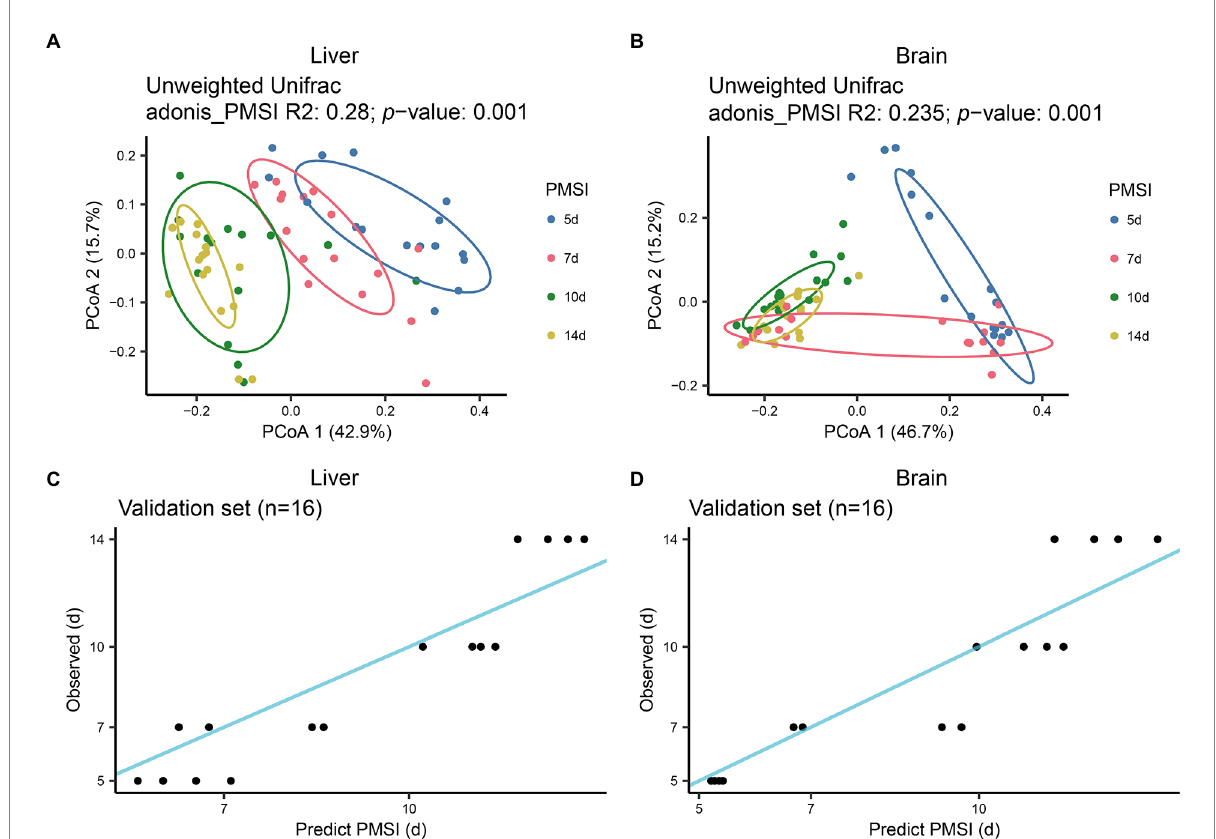
FIGURE 4 Successional dynamics of microbial communities in the liver and brain, and performances of regression models for PMSI estimation. PCoA of bacterial communities in liver (A) , and brain (B) . Different colors indicate different PMSIs. Predicted PMSI versus actual PMSI for liver (C) , and brain (D) , samples were plotted with a superimposed one-to-one reference line. Dots represent samples from the validation experiment ( n = 4 per